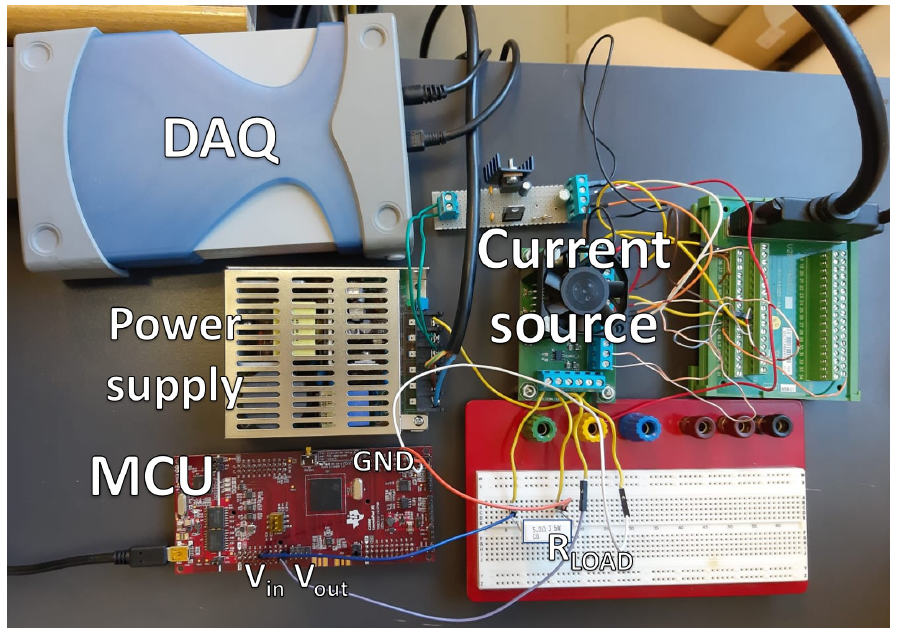
Figure 2. A picture of the prototype EIS measurement instrument and the impedance